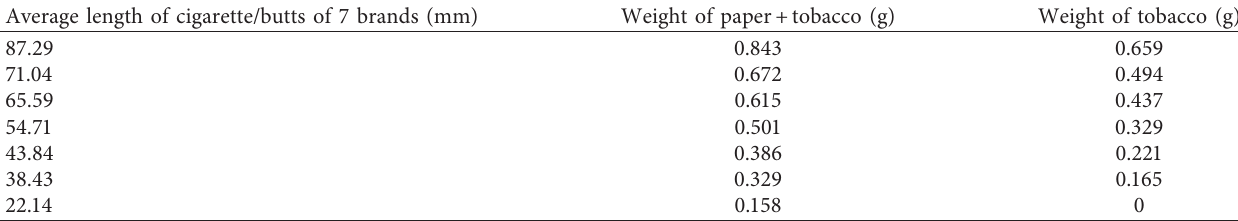
Table 2: Weight of remnant tobacco remained in different possible sizes of cigarette/butts.